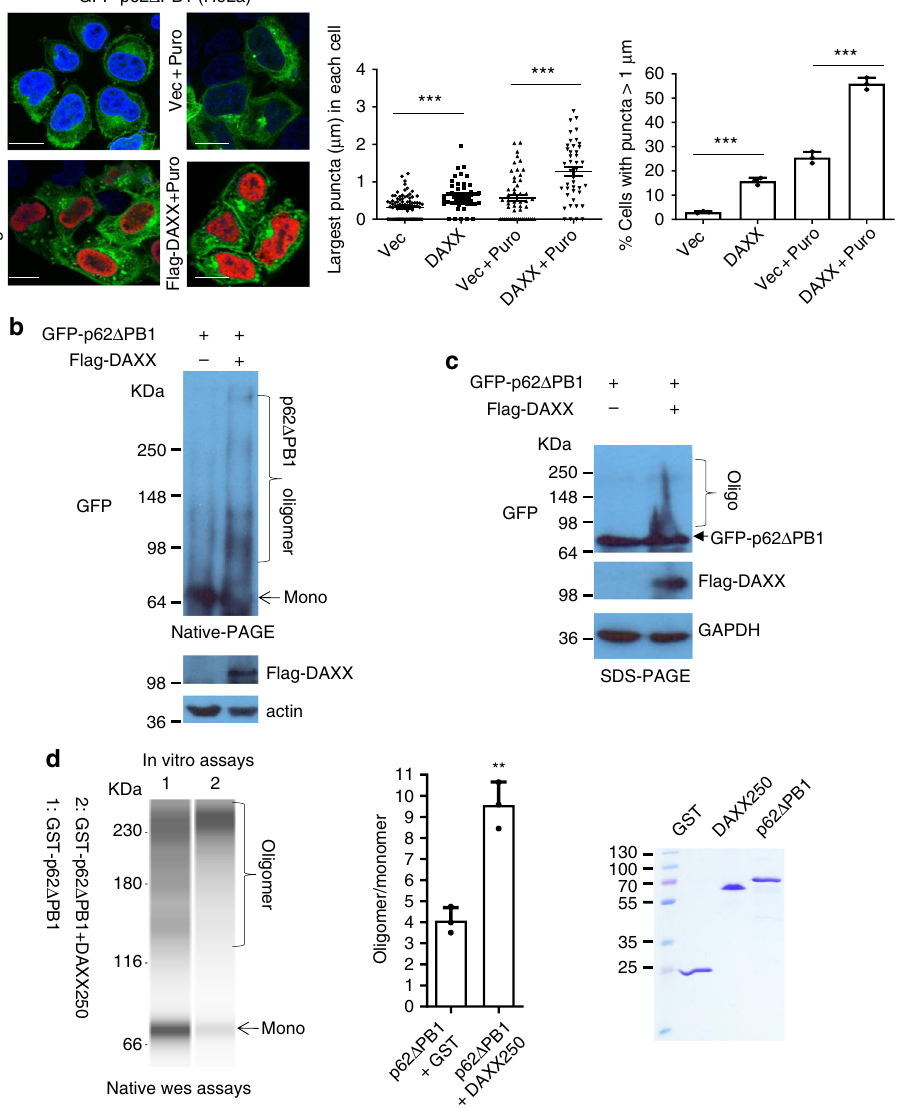
biomaterials. Sun et al. 29 reported the role of polyubiquitin chain in p62 phase separation. Zaffagnini et al. 41 consistently reported that p62 cluster formation is triggered by multiple ubiquitin chains in polyubiquitinated proteins. p62 droplets may exhibit an intermediate feature between solid and liquid phases (gel-like phase) 29,41 . Interestingly, the induction of polyubiquitin chains in